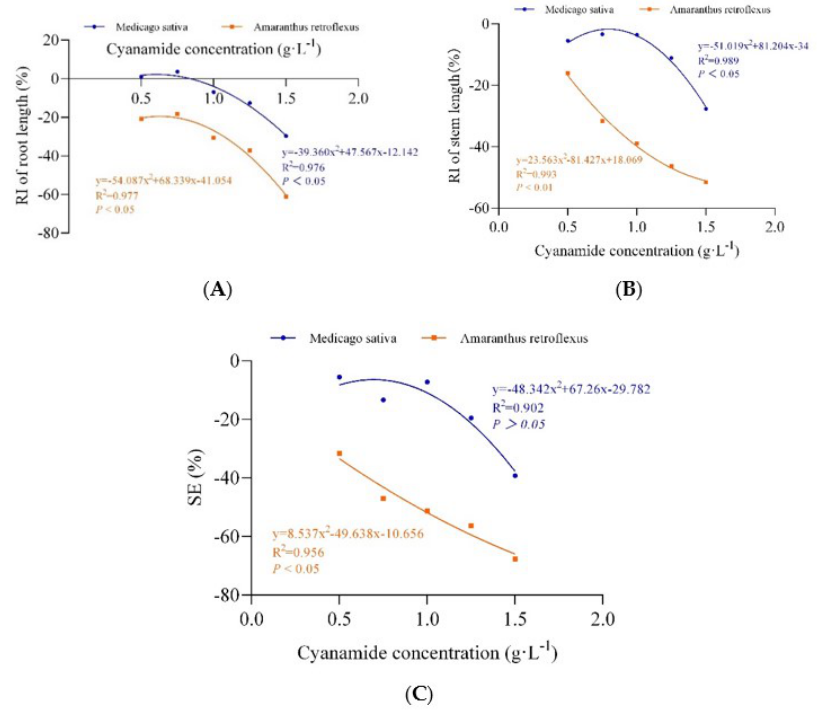
Figure 4. The non-linear fit of the response index of seedling root length (RI of root length), stem length (RI of stem length), and the synthetical allelopathic index (SE). ( A ) The non-linear fit of response index of root length (RI of root length). ( B ) The non-linear fit of response index of (RI of stem length). ( C ) The non-linear fit of synthetical allelopathic index (SE).